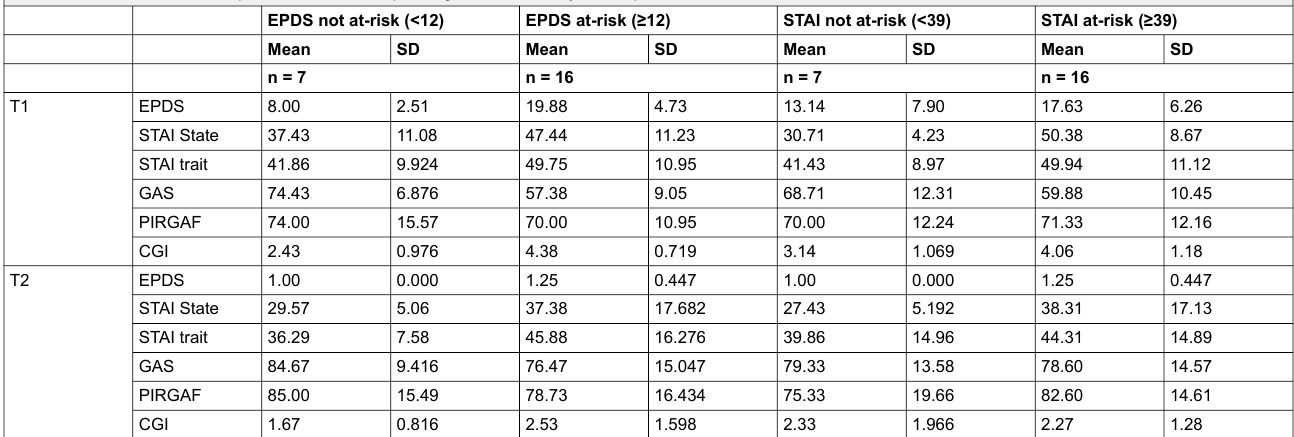
Table 4: Values of the most important measures depending on initial anxiety and depression. EPDS not at-risk (<12) EPDS at-risk (≥12) STAI not at-risk (<39) STAI at-risk (≥39) Mean SD